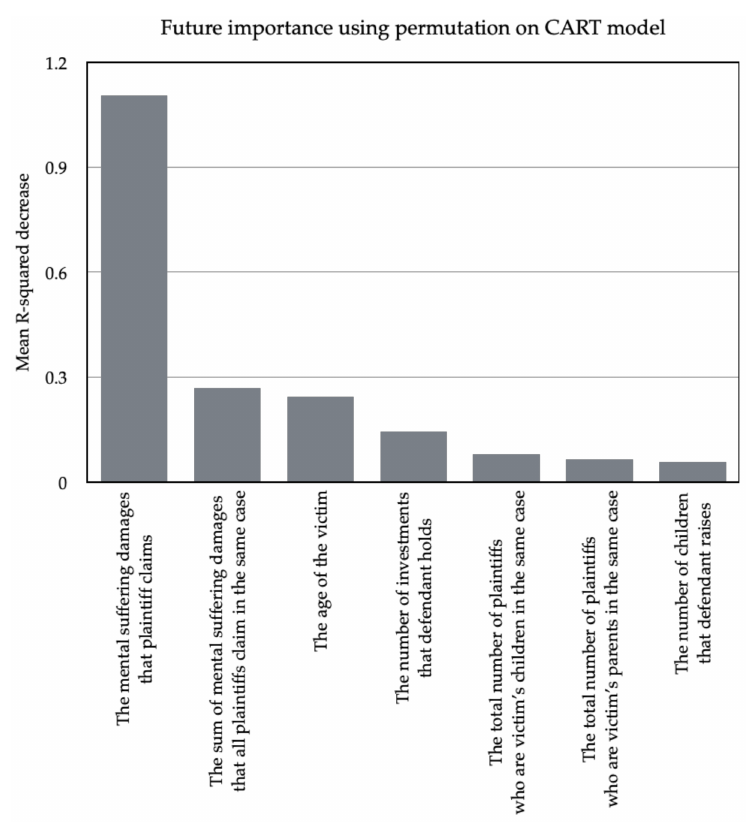
Figure 3. Feature importance using permutation on the CART